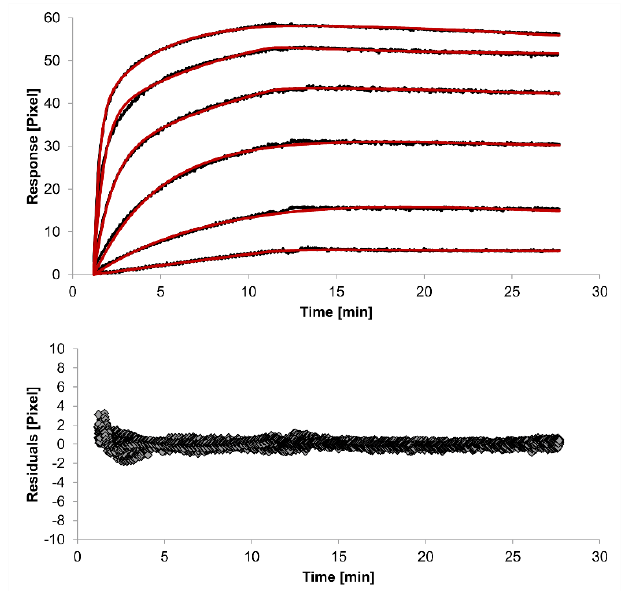
Figure 2. Kinetics of HSA-specific antibodies binding to immobilized HSA. Plots generated by applying the 1:1 binding model (red lines) overlay the plots associated with each antibody concentration (black lines; from top to bottom: 3.4 µM, 0.9 µM, 0.2 µM, 53.9 nM, 13.5 nM, 3.4 nM). Values resulting from the average of two sensing spots and the subtraction of reference surface signals from raw signal measurements are presented on the graph. The graph below depicts the residuals of the fits.